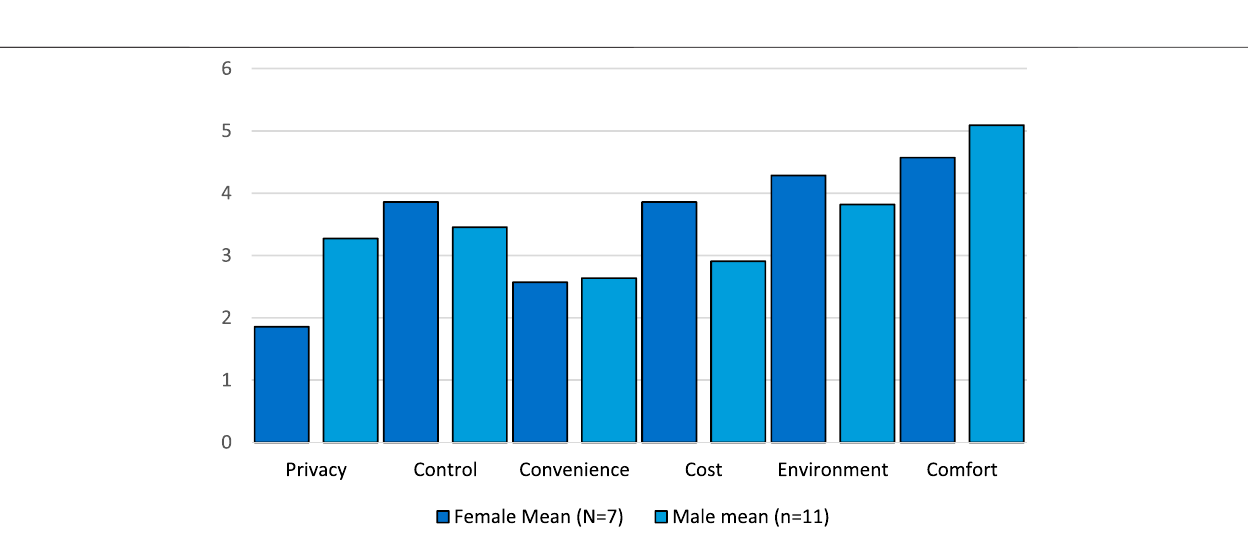
FIGURE 6 | Difference in survey counts for ‘ Comfortableness of using smart sysemts to monitor children ’ .Source, authors. Error bars indicate 95% con fi dence interval.